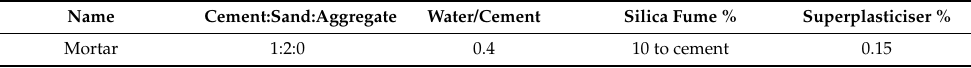
Table 1. Mixture conditions of mortar.